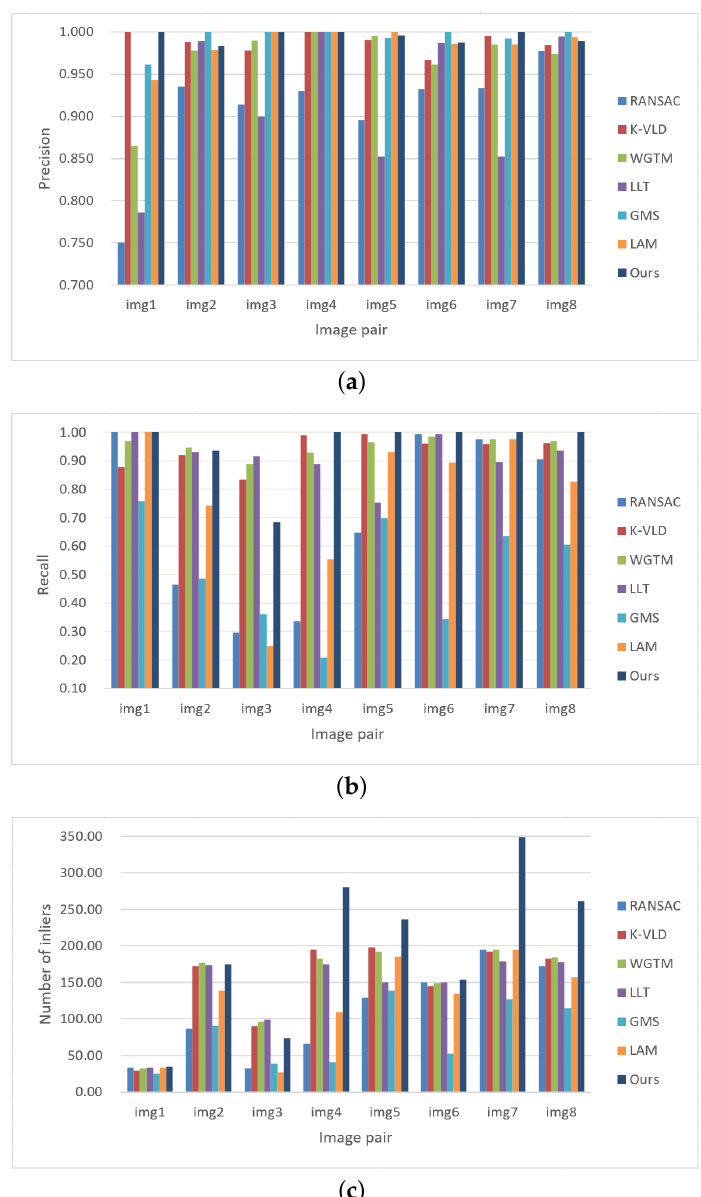
Figure 17. Statistical results for the non-rigid dataset (dataset 3): ( a ) precision; ( b ) recall; ( c ) number of